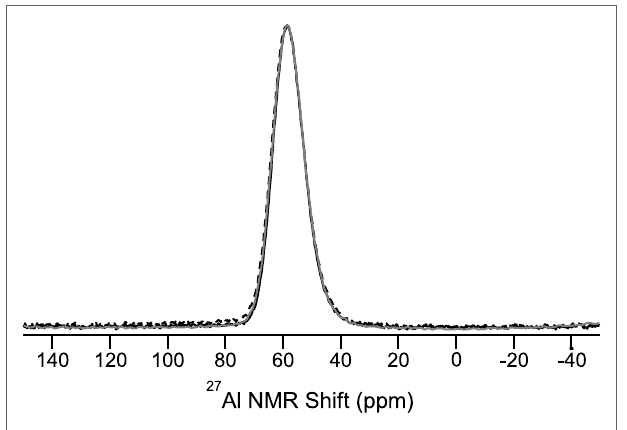
FigUre 11 | 27 al Mas nMr spectra of three different aluminosilicate glasses ion exchanged at 410°c: as-prepared (gray line), compressed at 1 gPa and 650°c (dashed black line), and annealed for 168 h at 0.92 T g (solid black line)